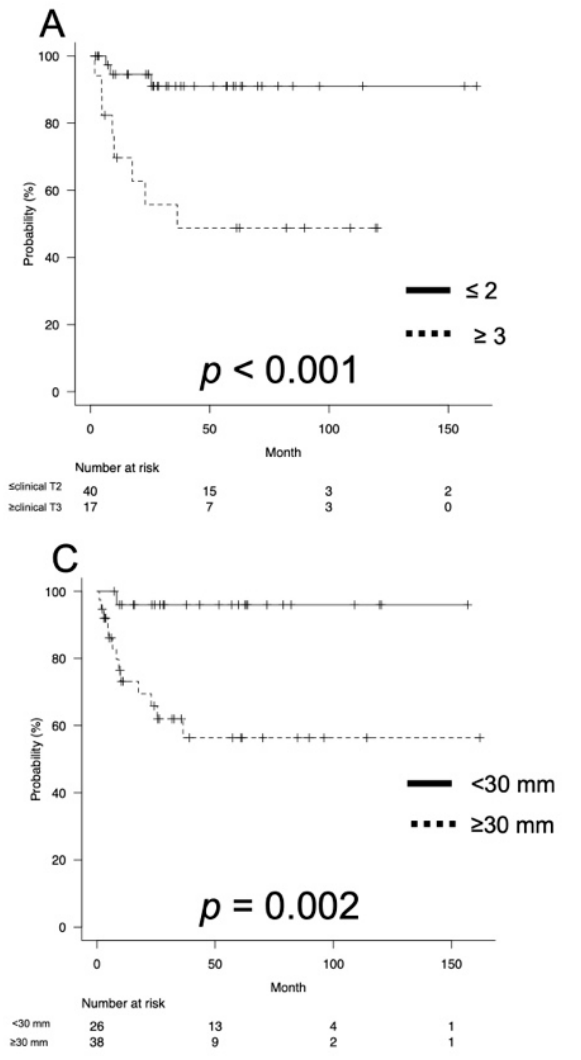
Figure 2. The Kaplan–Meier estimates of cancer-specific survival (CSS) according to the clinical T stage ( A ), lymph node status ( B ), and tumor size stratified by a cutoff of 30 mm ( C ). The 2-year CSS rates were 94.2% and 54.0% for clinical ≤ T2 and ≥ T3 stages, respectively ( p < 0.001; Figure 2A); 86.0% and 57.2% for patients with or without lymph node involvement, respectively ( p = 0.009; Figure 1B); and 96.0% and 65.9% for tumor size of <30 mm and ≥ 30 mm, respectively ( p < 0.001; Figure 1C). Table 2. Multivariate